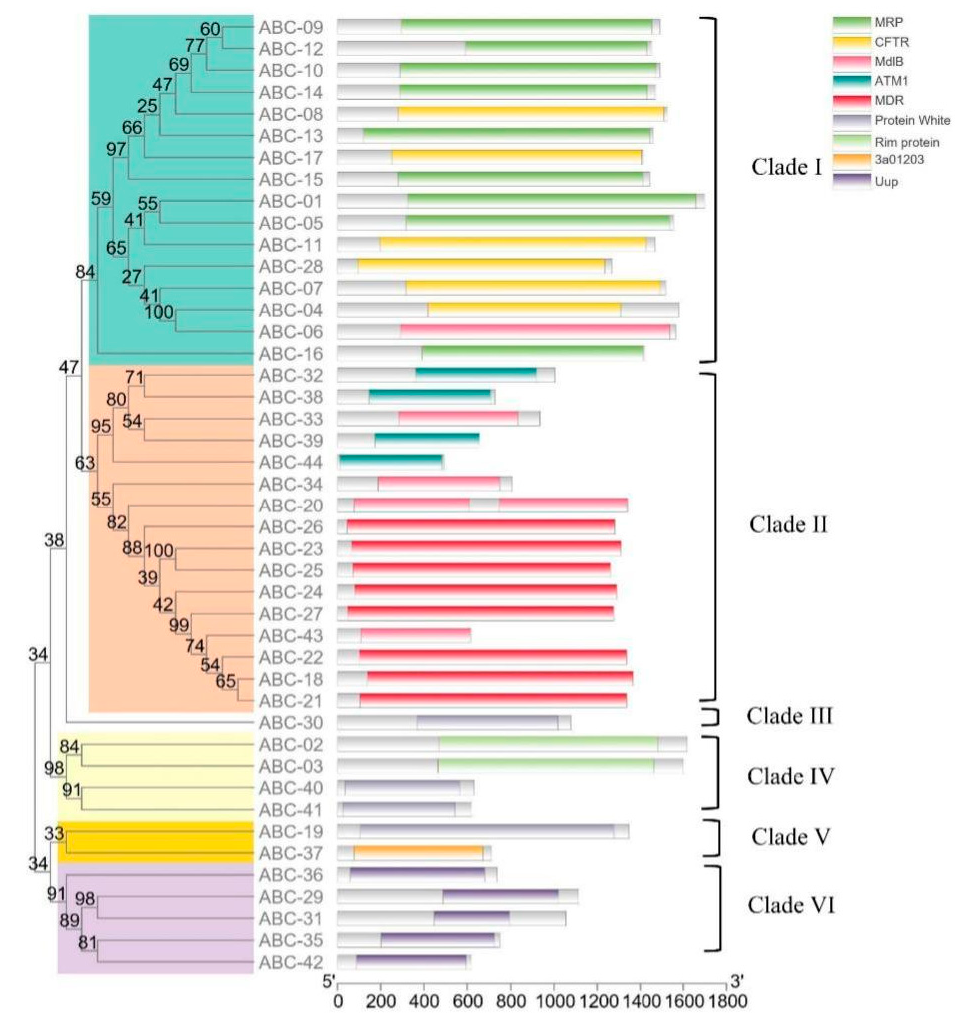
Figure 2. Phylogenetic analysis of the 44 ABC proteins. The phylogenetic tree was constructed using the maximum-likelihood method (model: LG + G + I + F) with 1000 bootstrap replicates in the MEGA 7.0 program. The positions of multidomains were drawn in the TBtools program.